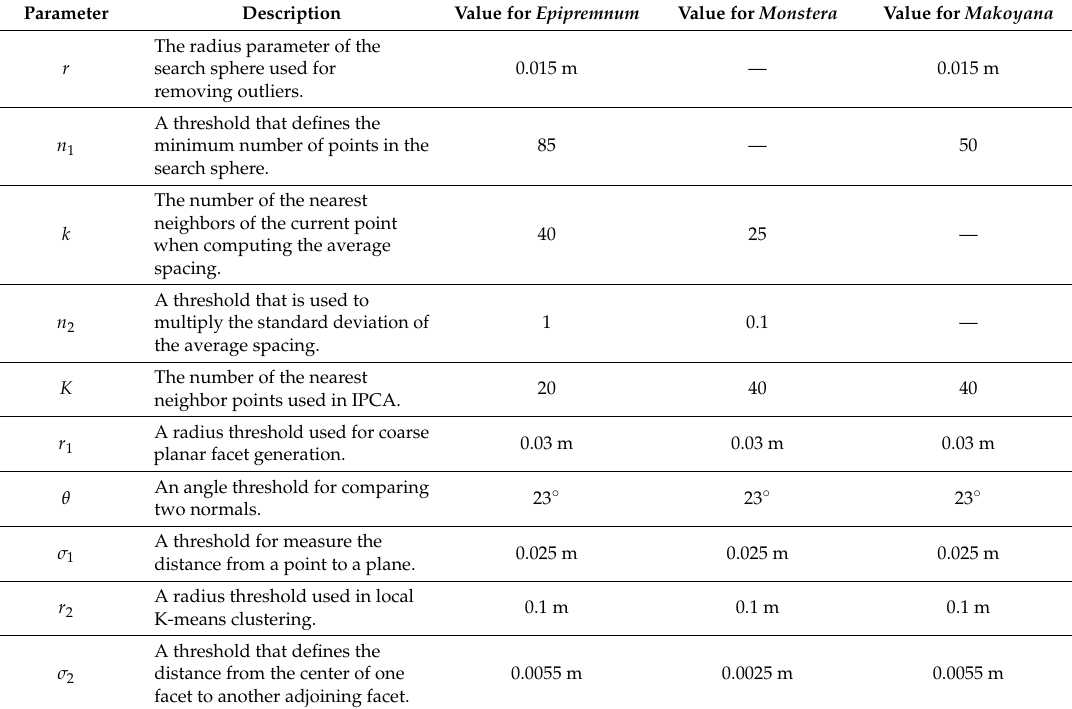
Table 1. Parameter settings for the three different point